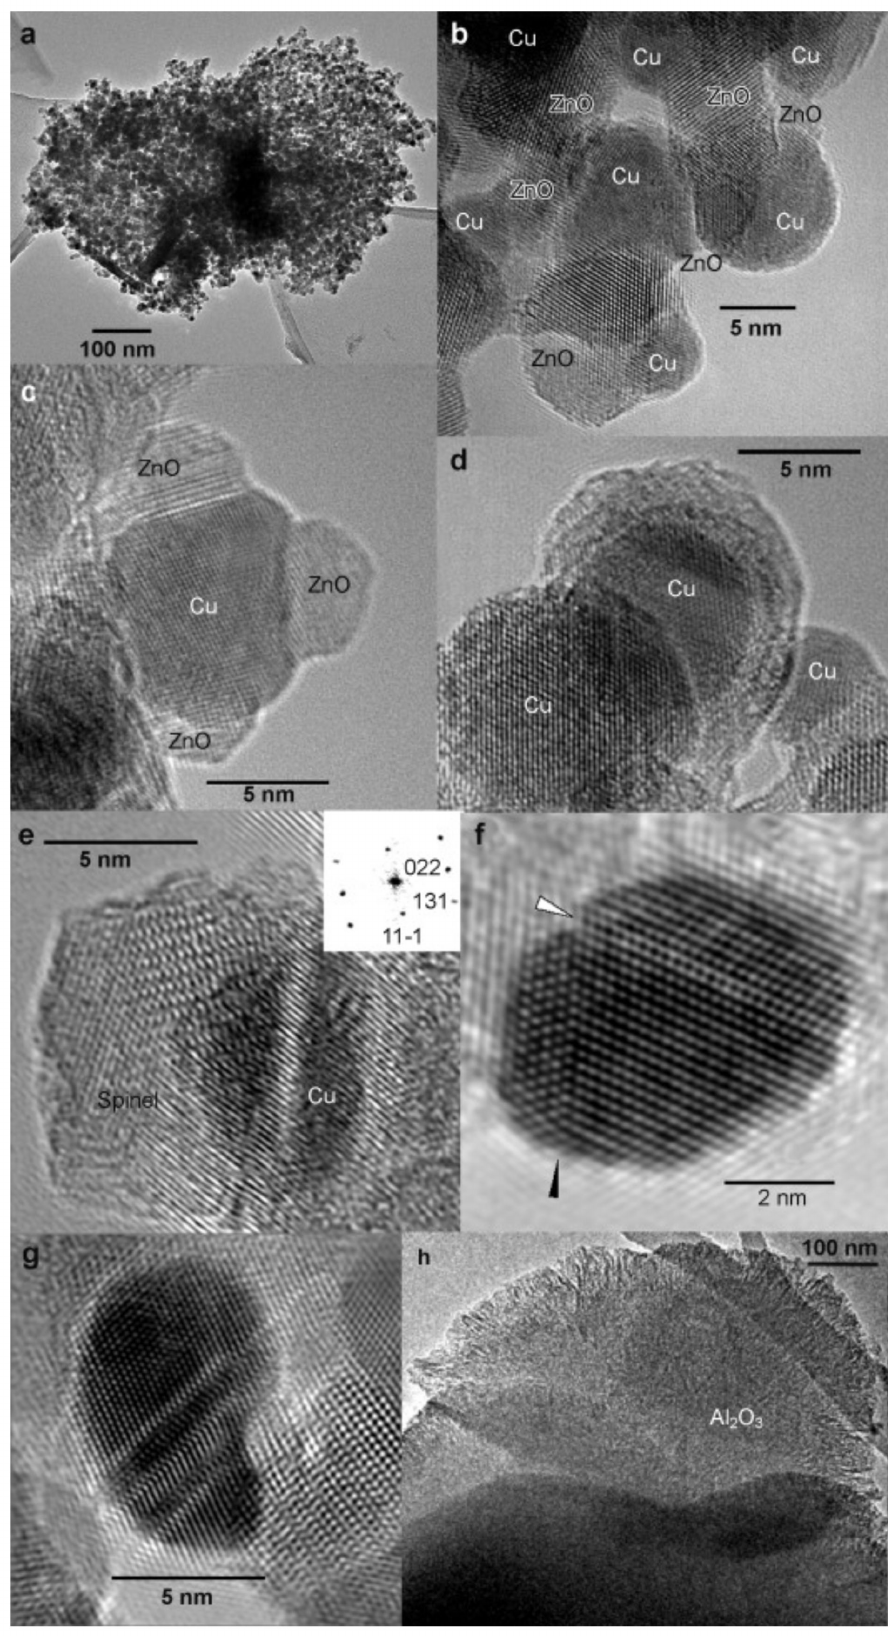
Figure 5. Microstructural characteristics with TEM and HRTEM experiments of the studied Cu/ZnO- based catalysts. (Adapted from [77], copyright 2007, John Wiley and